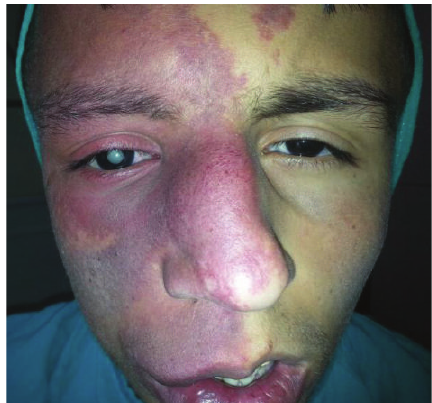
Figure 1: Mature cataract, port-wine stains, and asymmetric face in the right side.